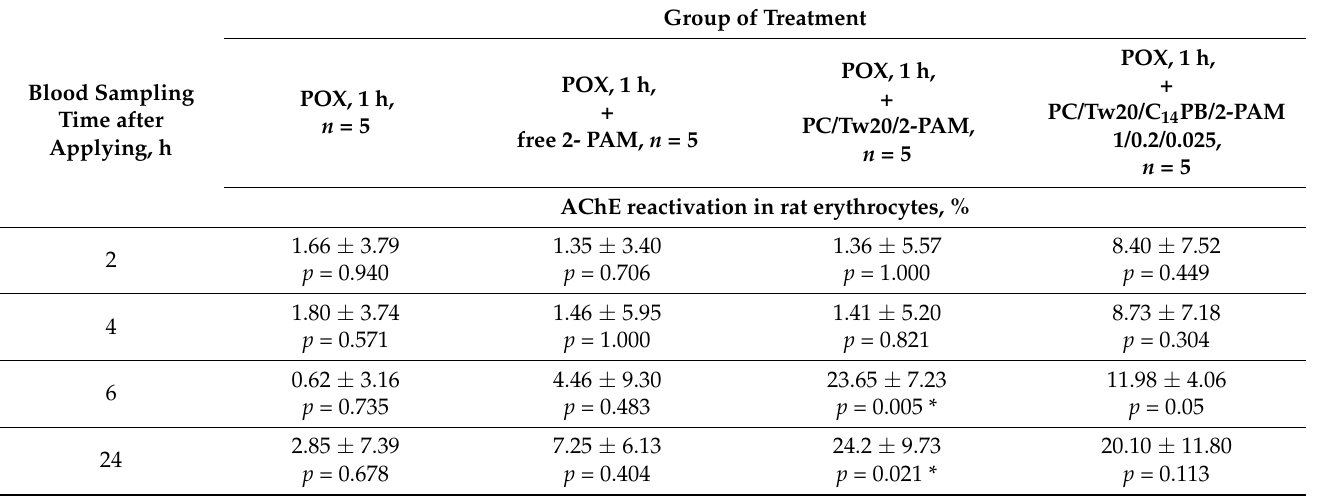
Table 4. AChE reactivation profile after transdermal administration of transfersomes loaded with 2-PAM.